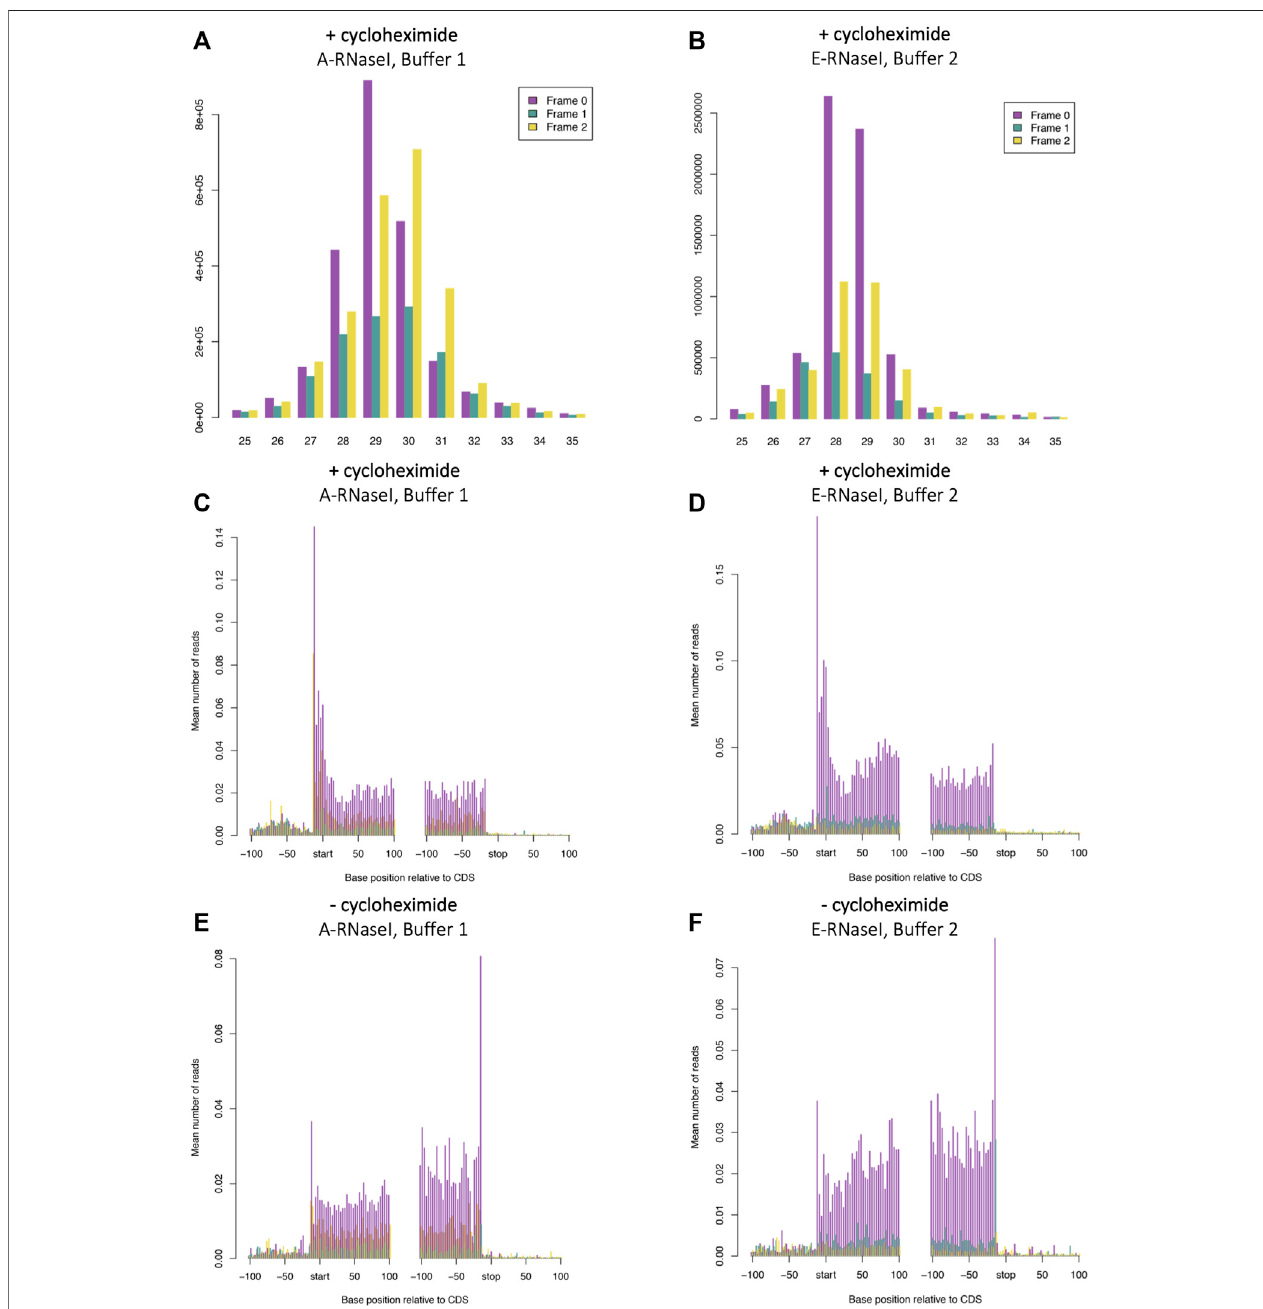
FIGURE 2 | Changes to RNaseI footprinting affects size and framing of ribosome footprints in Drosophila S2 cells. Read length distribution and frame plots from Ribosome footprinting in D. melanogaster S2 cells in (A) A-RNaseI and Buffer 1 (50 mM Tris-HCl pH8, 150 mM NaCl) and (B) E-RNaseI and Buffer 2 (100 mM Tris-HCl pH8, 30 mM NaCl) footprinting conditions, both in presence of cycloheximide (100 μ g/ml). Metagene plots from 29 nt ribosome footprints (C and E) A-RNaseI and Buffer1andmetageneplotsfrom 28 ntribosomefootprints (Dand F) E-RNaseIandBuffer 2footprintingconditions, eitherin (CandD) thepresenceor (E andF) absence of cycloheximide. Plots were generated with